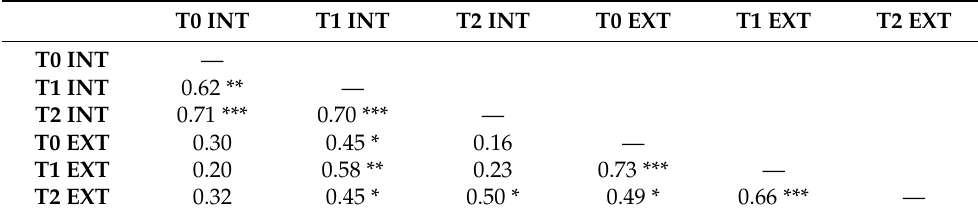
Table 3. Pearson Correlation Coefficients between Behavioral Problems at T0, T1, and T2.